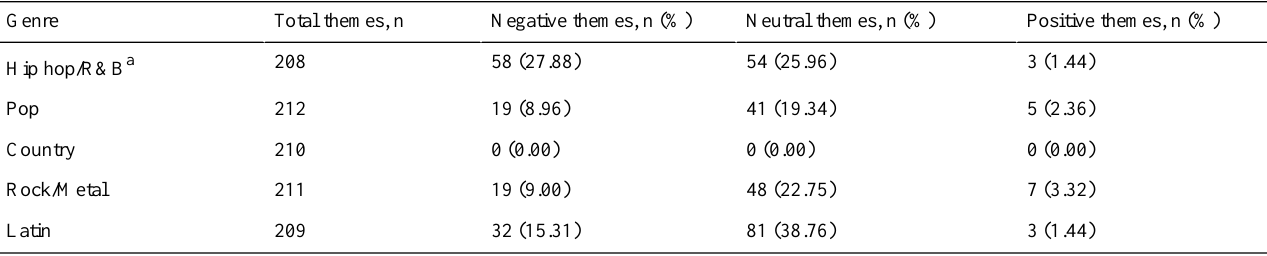
Table 5. Frequency of negative, neutral, and positive themes in music videos based on genres.